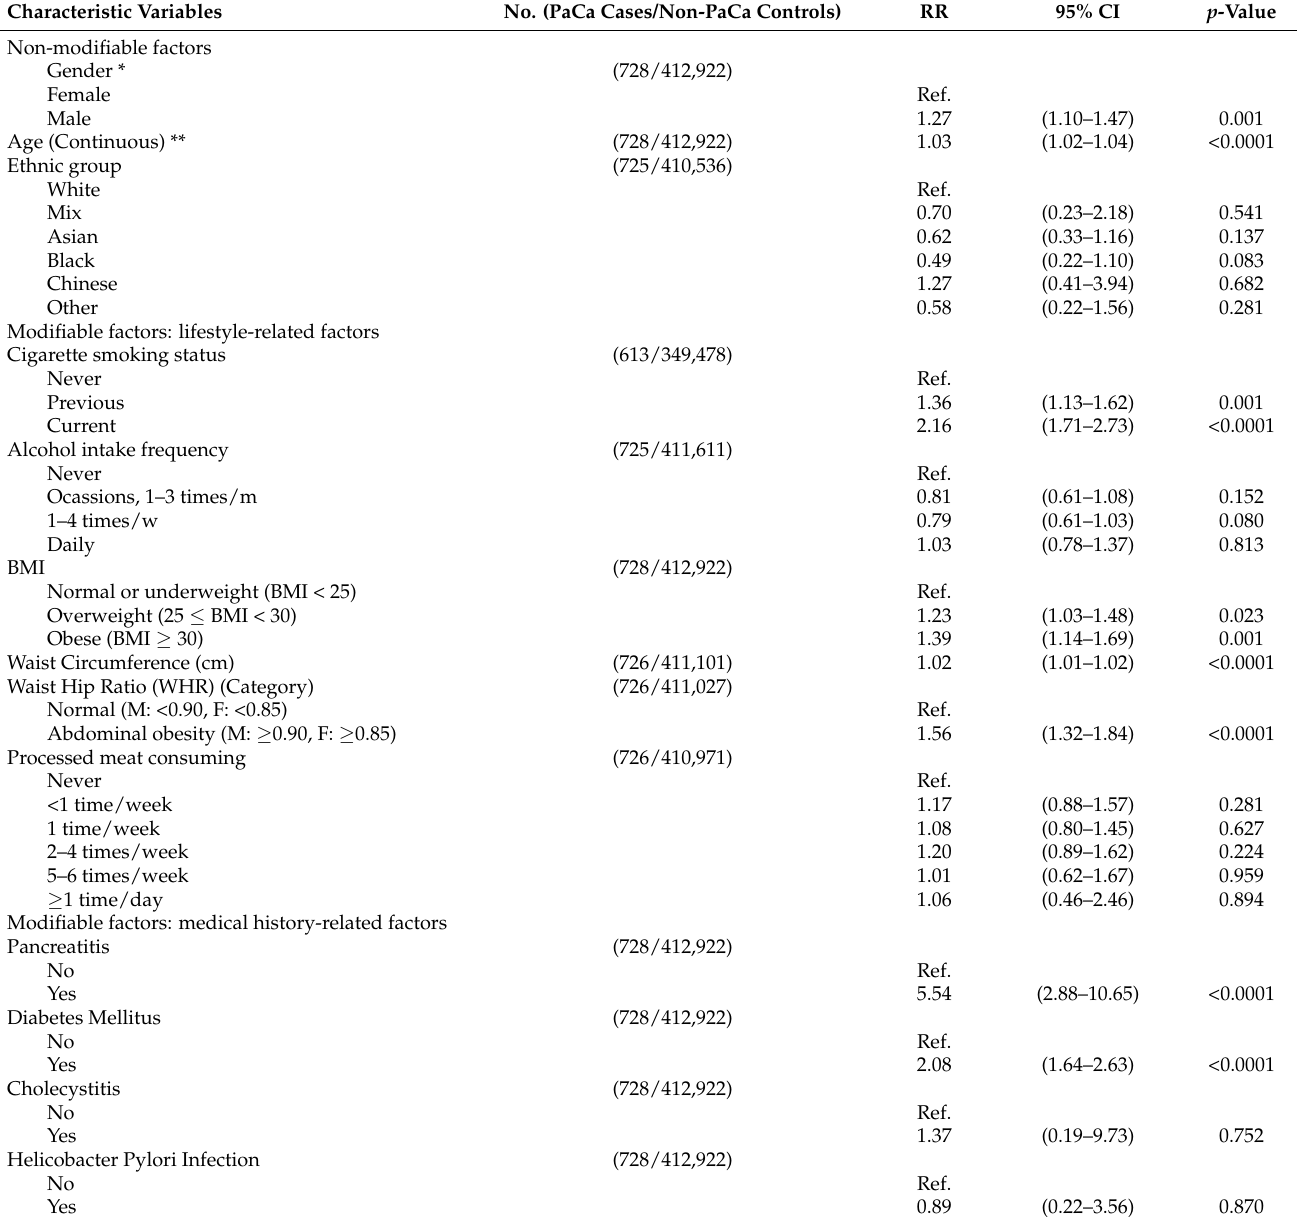
Table 2. Pancreatic cancer (PaCa) relative risk (RR) of non-modifiable and modifiable